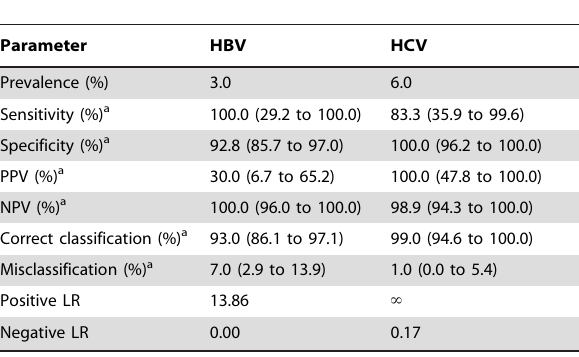
Table 5. Diagnostic performance of the HepaTrio test for detecting HBV and HCV infections from a total of 100 hemodialysis